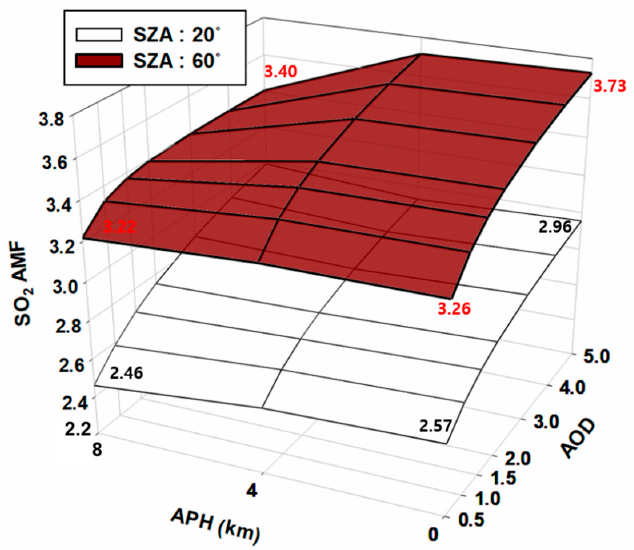
Figure 9. Changes in volcanic SO 2 AMF as a function of AOD and APH at low and high SZA (VZA = 40°; RAA = 45°; surface reflectance = 0.05; O 3 VCD = 275 DU; wavelength = 375 nm; aerosol type = volcanic ash).